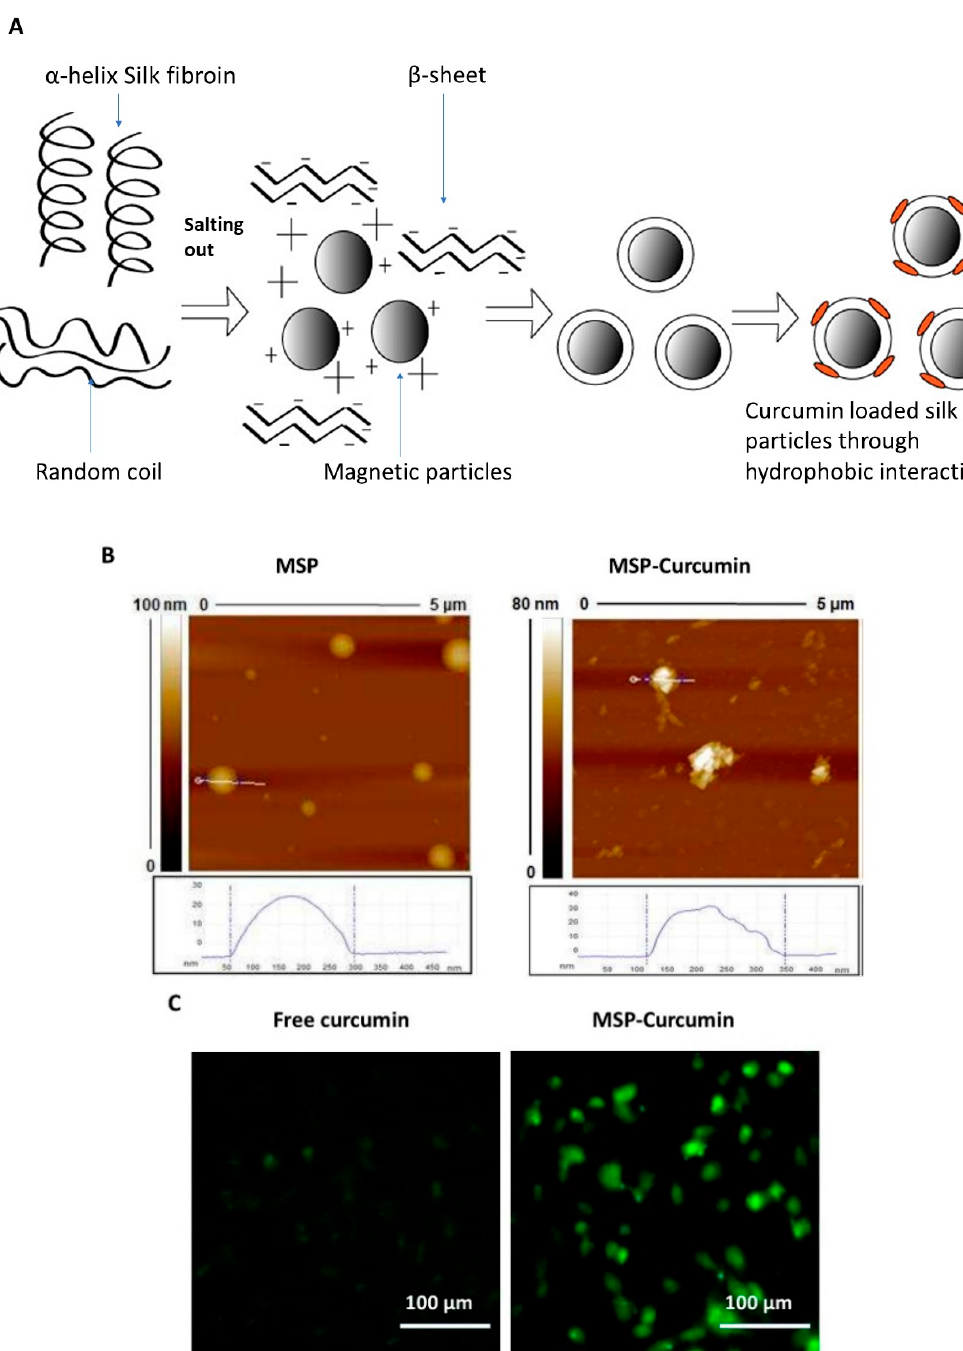
Figure 4. ( A ) Fabrication of magnetic silk particles (MSP) for curcumin delivery. ( B ) Atomic force microscopy (AFM) images of MSP before and after curcumin loading. ( C ) Representative microscopic images of MDA-MB-231 cells incubated with free curcumin and curcumin-loaded MSP showing a significant improvement of curcumin cellular uptake. Reprinted from Song et al. [54], copyright © 2017 ACS.